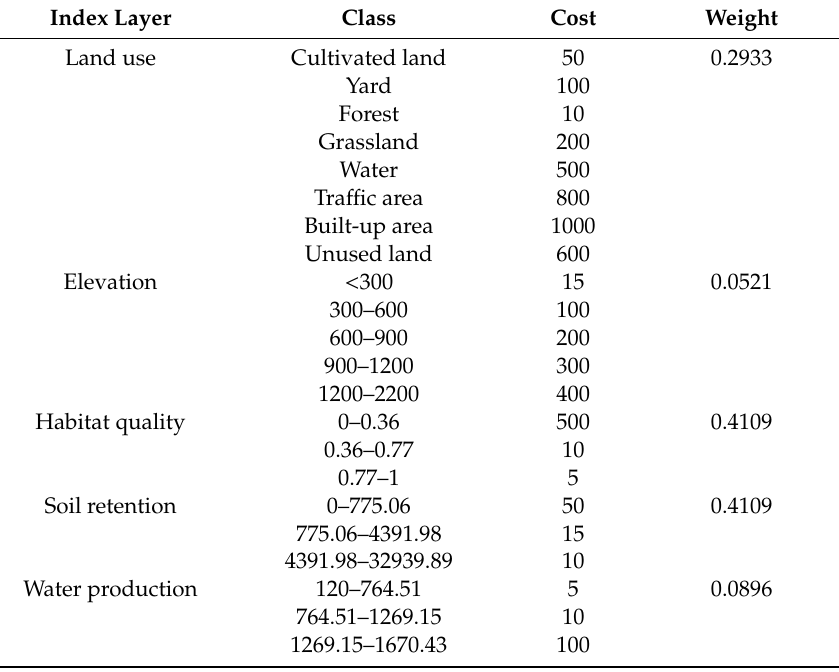
Table 5. Score and weight of the resistance factors in the study area.